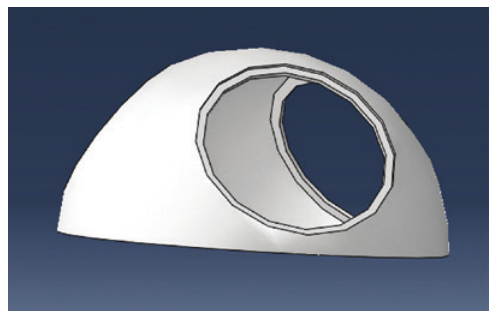
Figure 2: Simplified model of the spherical shell for VCS.